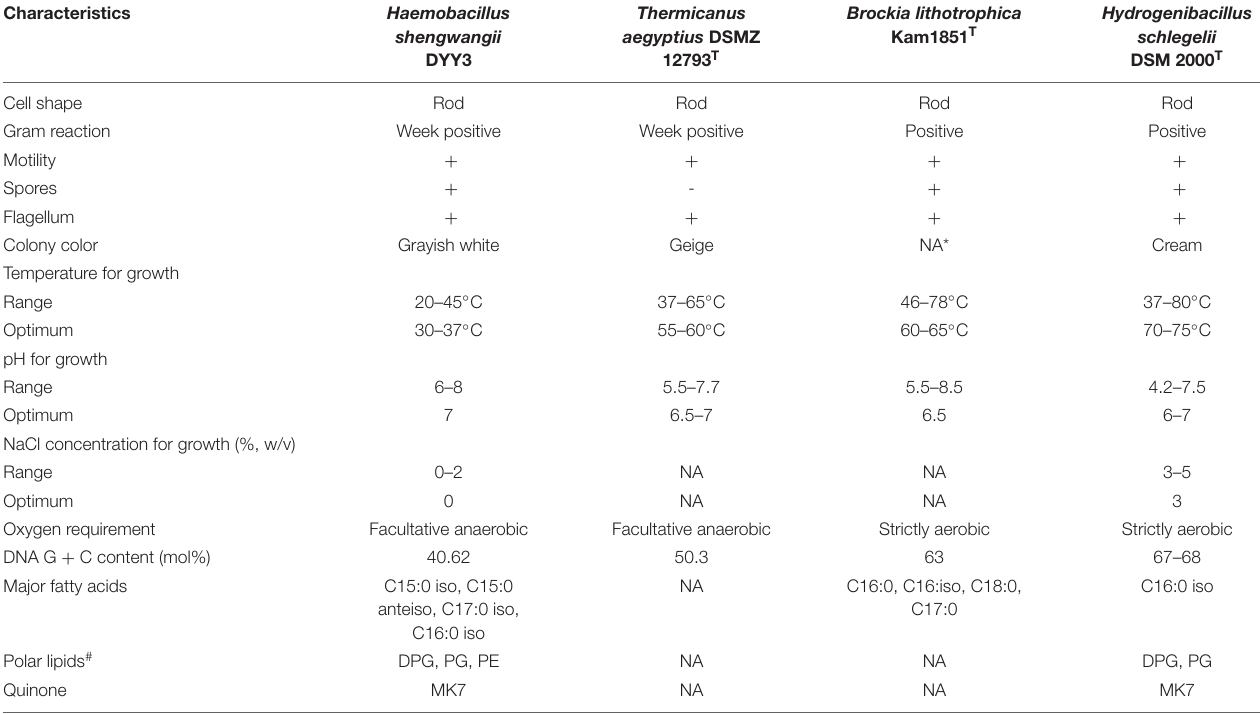
TABLE 1 | Characteristics of Haemobacillus shengwangii and close